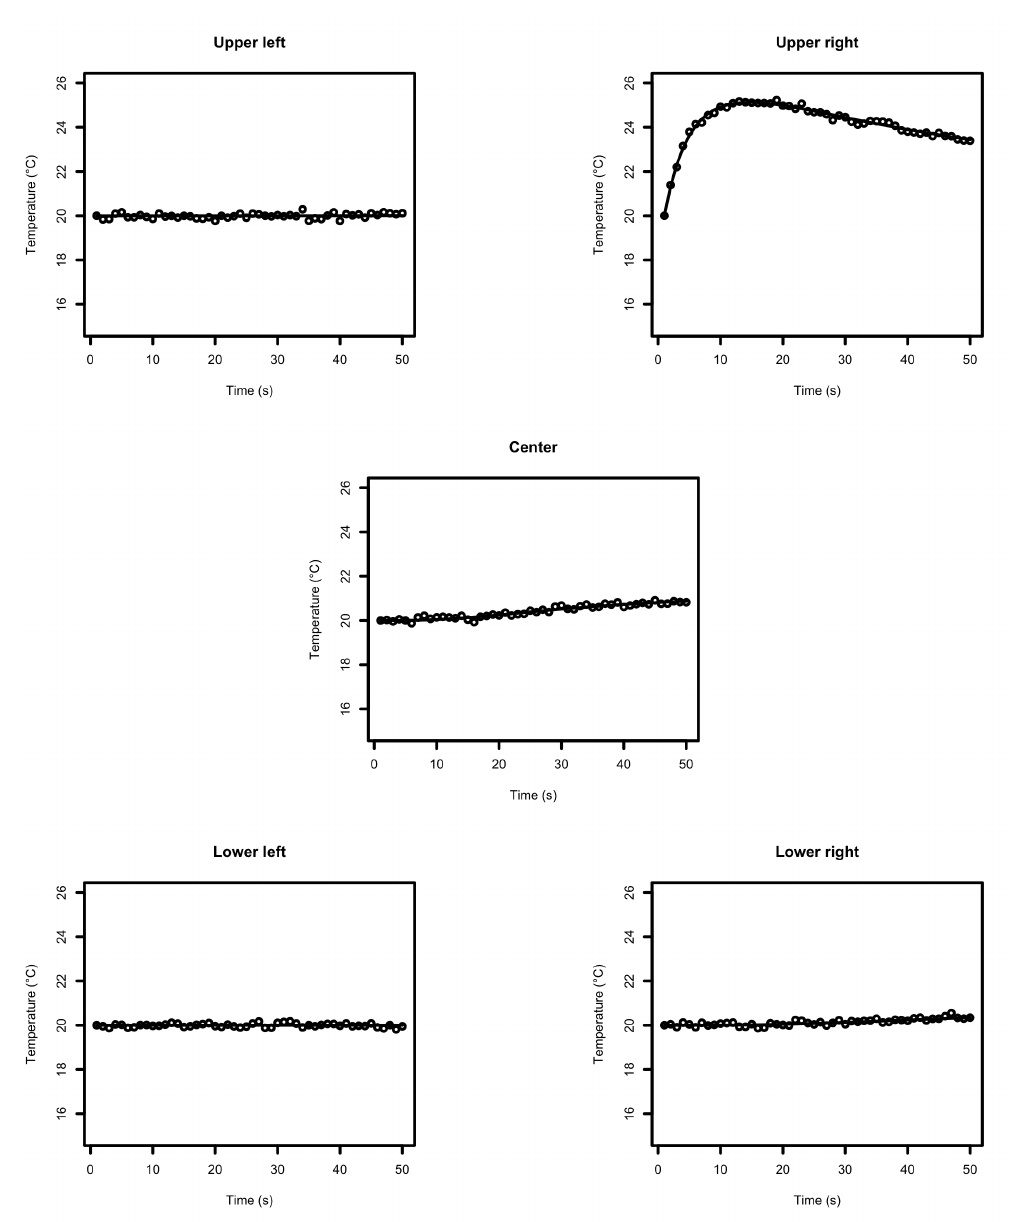
Figure 14. Data collected over time (points) and true temperature ( ◦ C) evolution at the data collection points